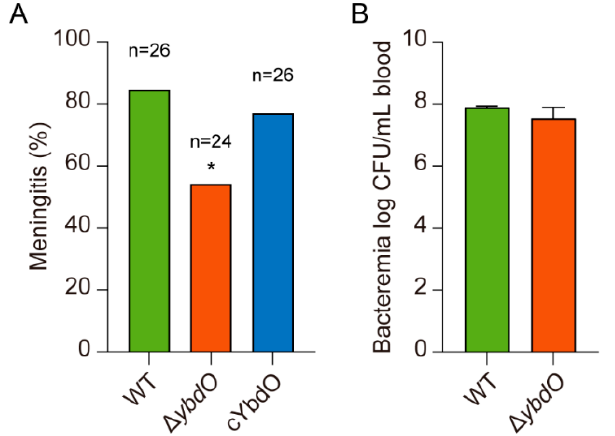
Figure 3. YbdO promotes E. coli K1-mediated meningitis without changes in high-level bacteremia. ( A ) Comparison of the number of animals with positive CSF cultures for E. coli between three groups receiving E. coli K1 WT, ∆ ybdO , and cybdO . ( B ) Deletion of ybdO did not affect the magnitude of E. coli K1 bacteremia in mice. Bacterial counts in the blood (log CFU/mL) were determined 4 h after intravenous injection of E. coli K1 strains via tail vein. Data were analyzed using ( A ) a two-sided Fisher’s exact test and ( B ) Student’s t -test. * p < 0.05.